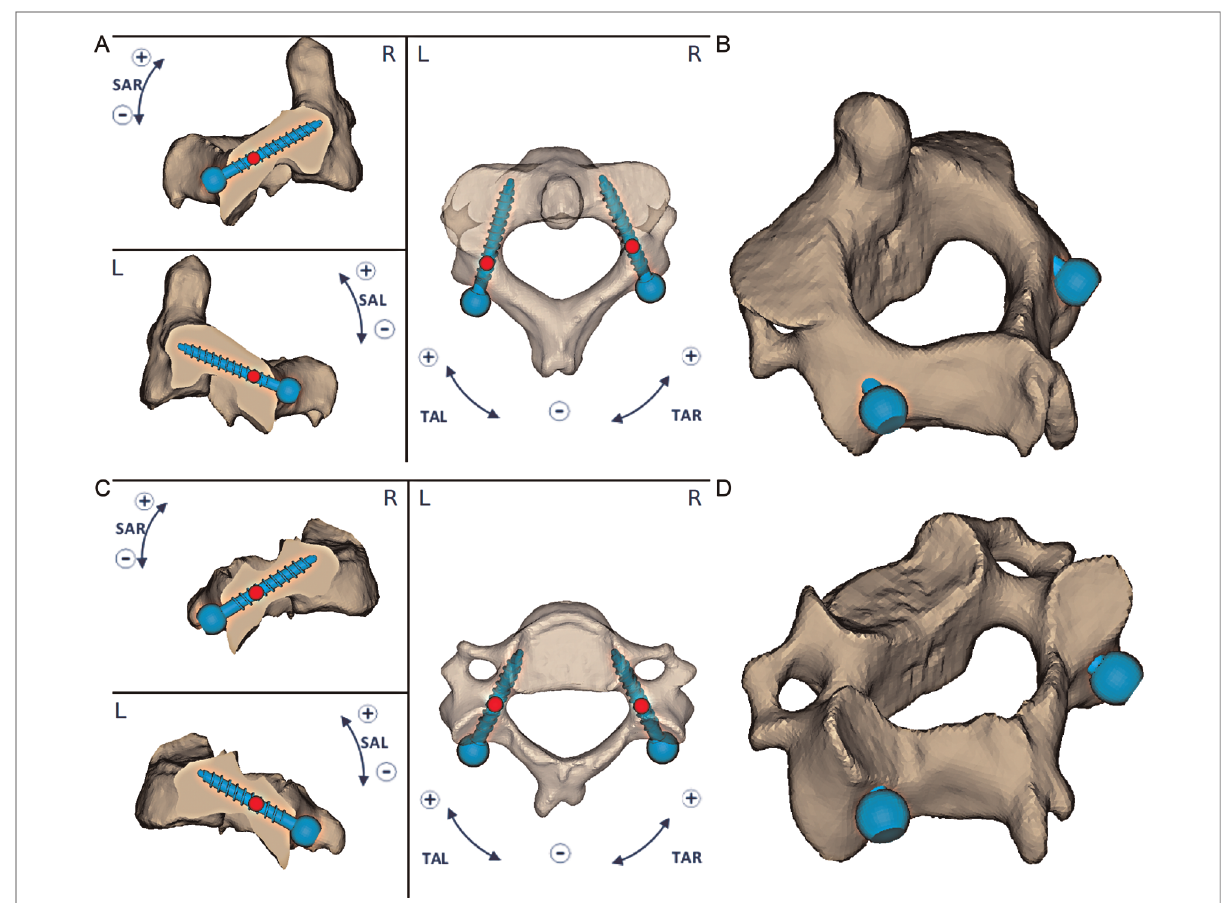
FIGURE 2 An occipitocervical fusion was planned after endoscopic endonasal removal of the lesion. A preoperative planning of C2 – C3 pedicle screws was reproduced. The 3D-printed guides were manufactured considering values of sagittal plane angle (SAL or SAR) and transverse plane angle (TAL or TAR) of screws, horizontal and vertical distances, screw directions and angulations and their entry points ( A , C ); C2 and C3 3D planning were shown ( B , D